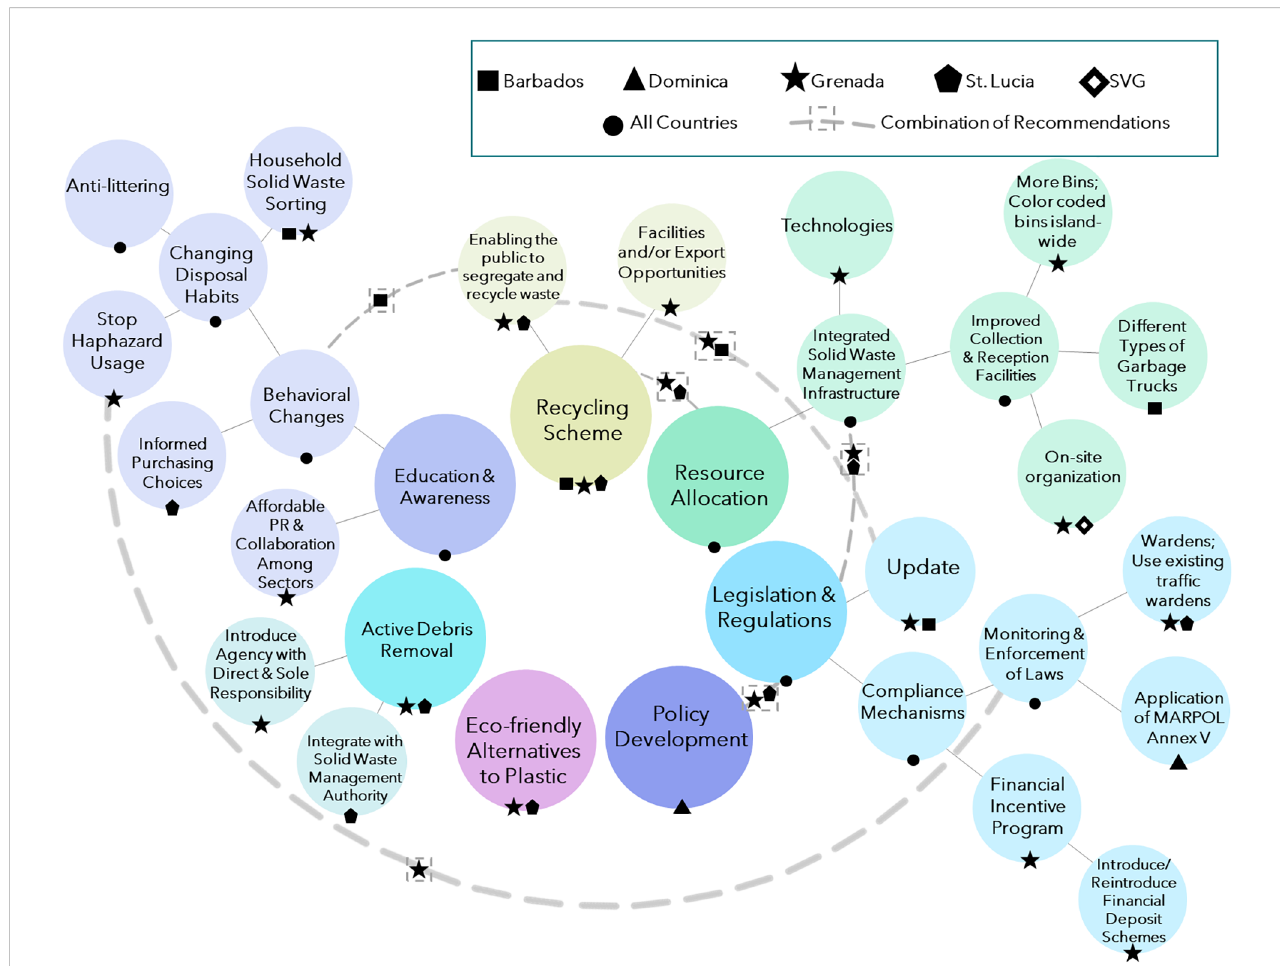
FIGURE 10 Seven major suggestions coming out from the participants ’ suggestions to tackle their constraints. The various symbols represent a particular country as listed in the legend. Each country has one or more representatives that made the